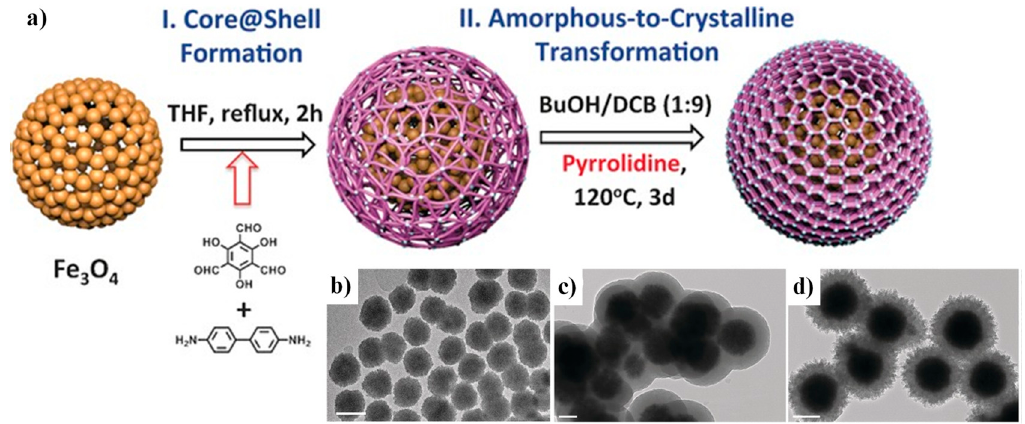
Figure 3. ( a ) The preparation of imine-linked COF composite microspheres via the amorphous-to- crystalline conversion process. High-resolution TEM images of ( b ) Fe 3 O 4 nanoparticles, ( c ) amorphous Fe 3 O 4 @polyimine, and ( d ) Fe 3 O 4 @COF(TpBD) microspheres. Reprinted with permission from